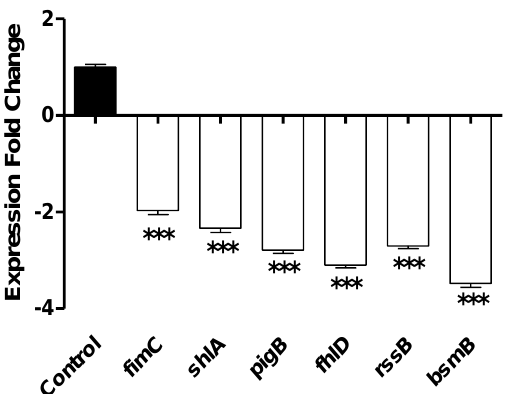
Figure 6. The effect of sodium citrate at 5% expression of virulence genes in S. marcescens . Citrate at 5% significantly decreased the expression of the virulence encoding genes The One − way ANOVA test was employed to assess significance; ***: p ≤ 0.001.